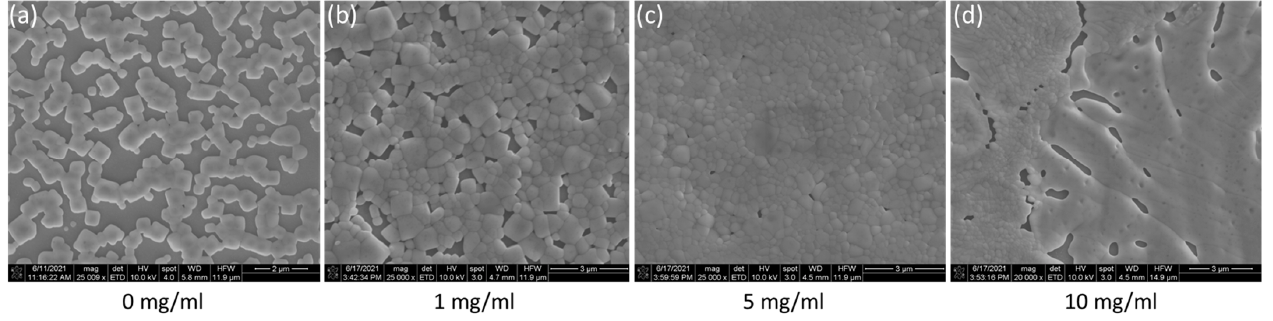
Figure 4. SEM images of perovskite films with ( a ) 0, ( b ) 1, ( c ) 5, and ( d ) 10 mg/mL of MgI 2 interfacial layer.